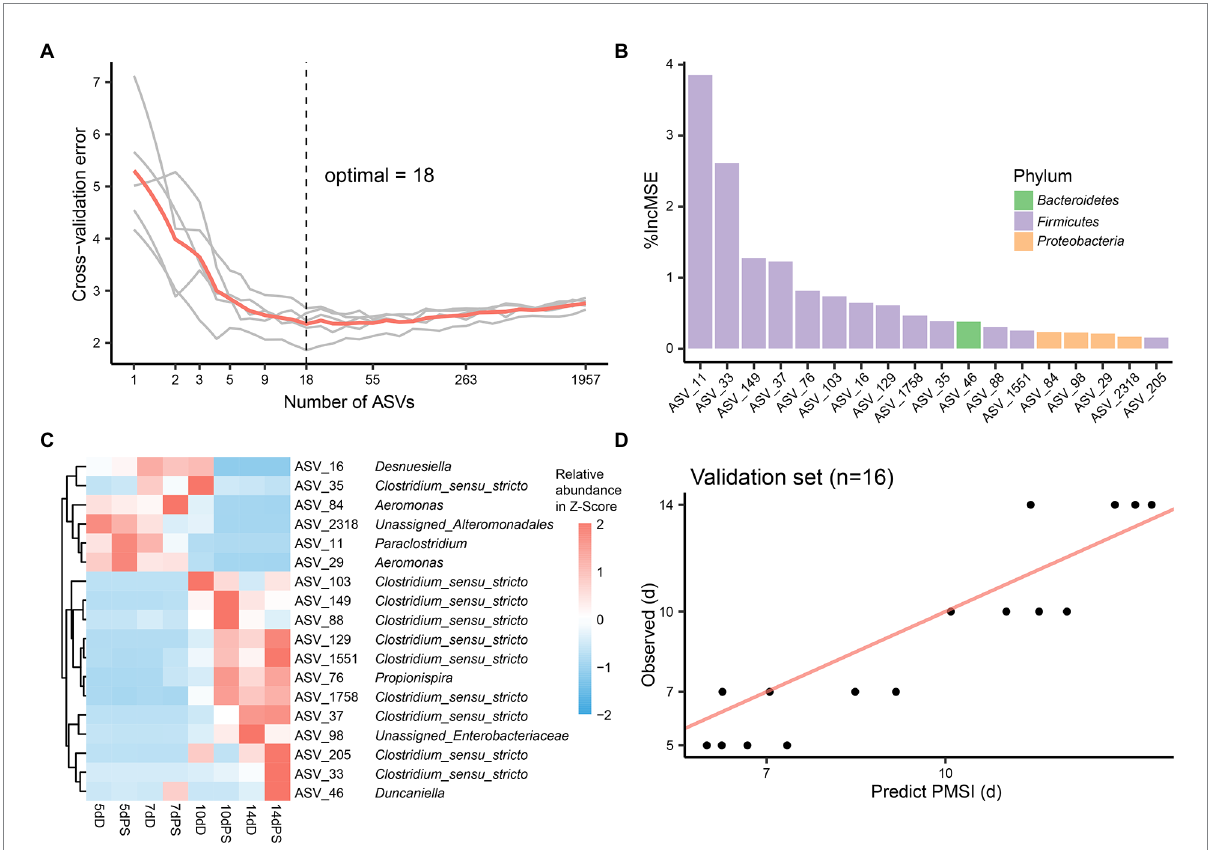
FIGURE 5 Liver biomarker identification and validation for PMSI estimation. (A) Cross-validation results of the initial model established using liver microbial communities. (B) The top 18 ASVs were identified by the RF algorithm. Biomarker taxa were ranked in decreasing order of importance (i.e., %IncMSE). (C) Heatmap demonstrating dynamic changes in abundance of the top 18 PMSI-predictive biomarkers. (D) Predicted PMSI versus actual PMSI for liver samples obtained by the refined regression model plotted with a superimposed one-to-one reference line. The dots represent liver samples from the validation experiment ( n = 4 per